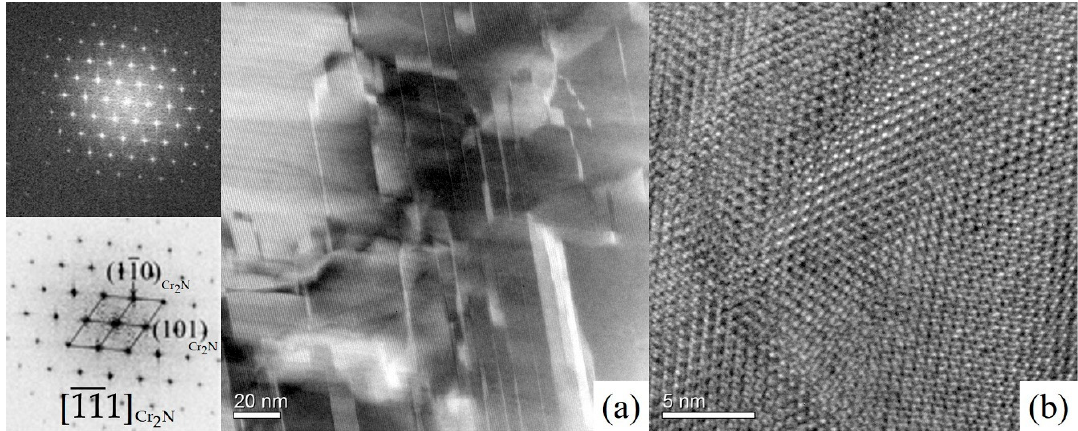
Figure 3. ( a ) TEM micrograph showing the substructure of Cr 2 N ( b ) HRTEM image recorded along the [1 (cid:3364) 1 (cid:3364) 1] zone axis showing that Cr 2 N has a complex microstructure characterized by separation into different regions.